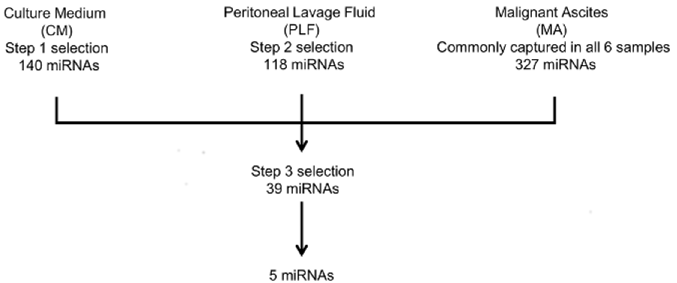
Fig 5. Identification of five exosomal miRNAs related to peritoneal dissemination. Schematic representation of the step-wise approach to screening miRNAs related to peritoneal dissemination. Step 1: selection of miRNAs differentially expressed (fold-change, > 2) in culture medium (CM) of the highly metastatic peritoneal cell line OCUM-2MD3 (OCUM-2M parental cell line was used as control). Step 2: six peritoneal lavage fluid (PLF) samples were divided into T4 (n = 4) and T1 – T3 groups according to gastrointestinal cancer stage; miRNAs differentially expressed (fold-change, > 2) in the T4 group were selected. Step 3: the selected miRNA species common for Steps 1 and 2 and expressed in malignant ascites (MA) with signal intensity > log 2 10 in MA and PLF were considered as candidate miRNAs related to peritoneal